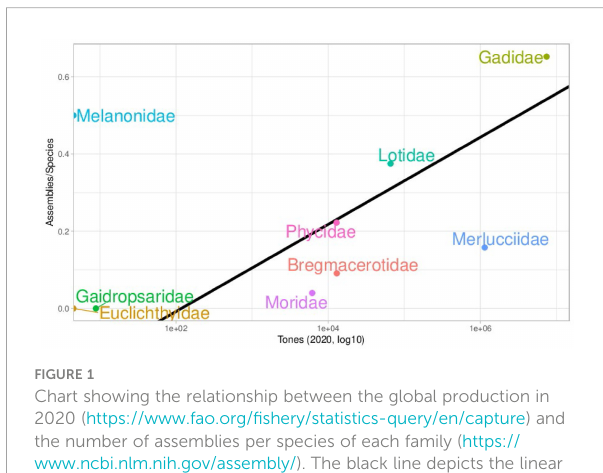
FIGURE 1 Chart showing the relationship between the global production in 2020 (https://www.fao.org/ fi shery/statistics-query/en/capture) and the number of assemblies per species of each family (https:// www.ncbi.nlm.nih.gov/assembly/). The black line depicts the linear regression